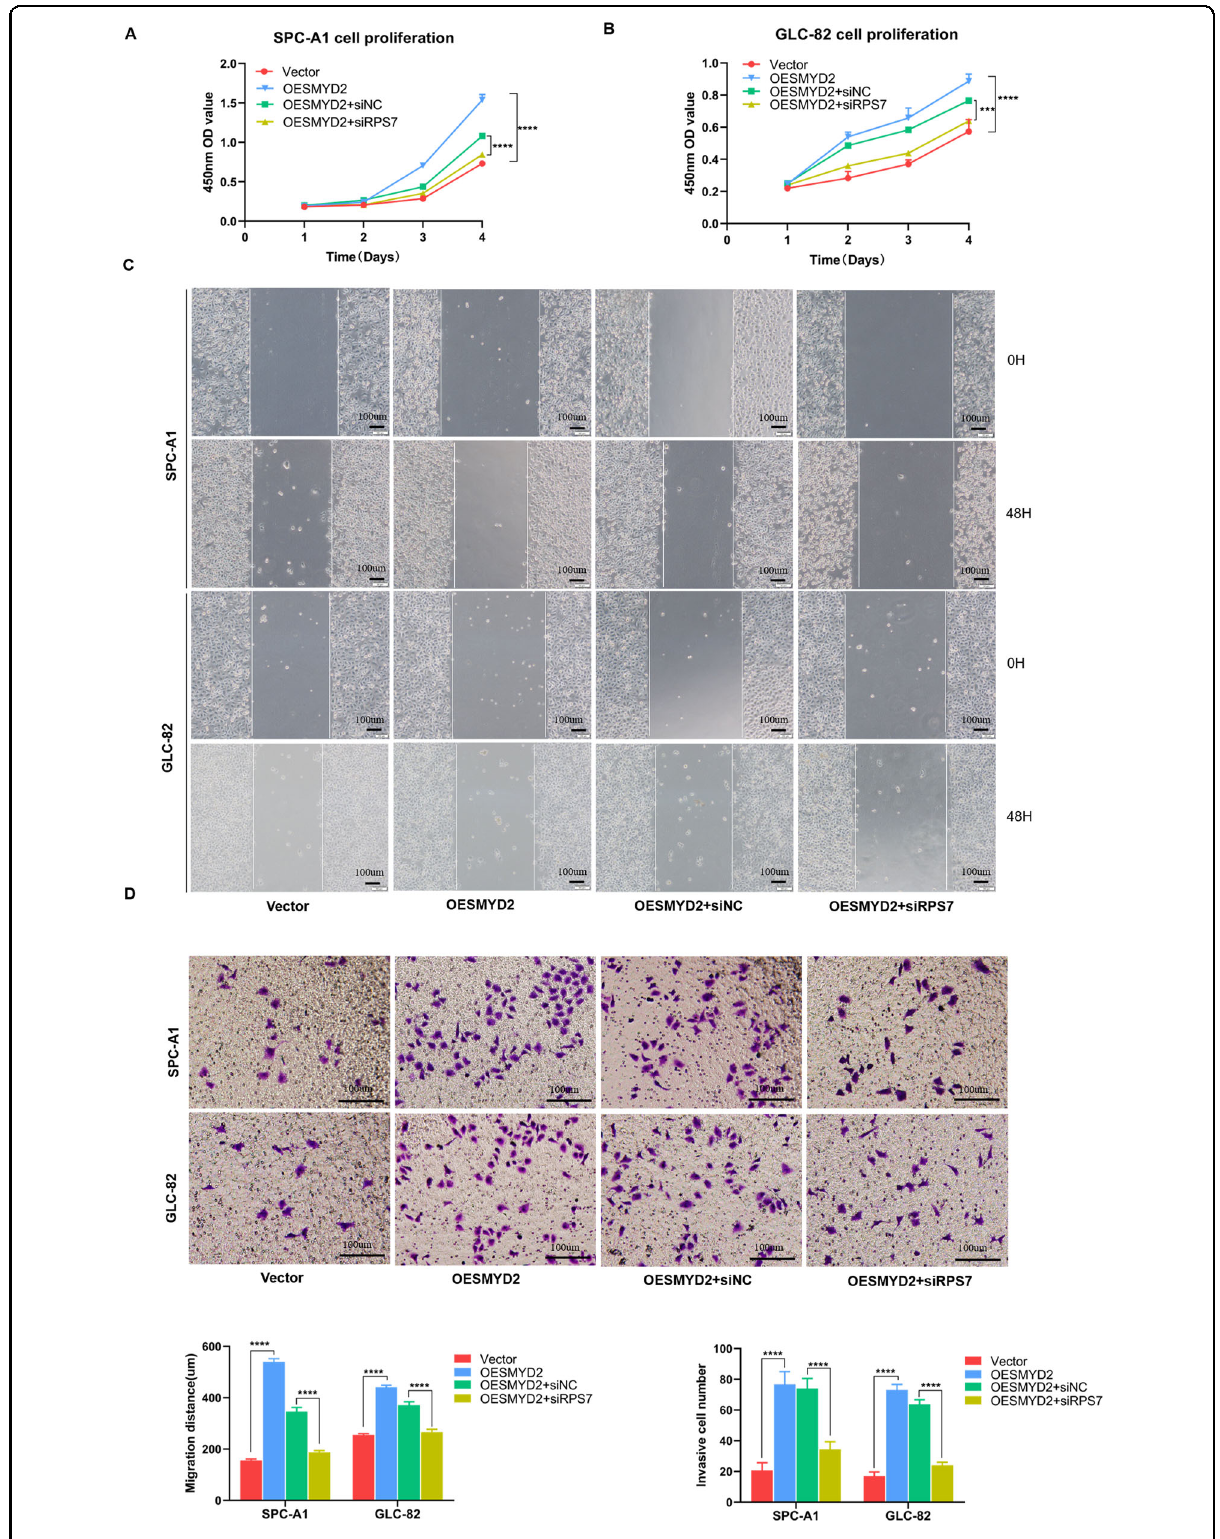
Fig. 6 SMYD2 promotes LUAD carcinogenesis and metastasis mediated by RPS7. A , B CCK8 assay showed that RPS7 depletion partially reversed SMYD2-enhanced proliferation in SPC-A1 and GLC-82 cells. C , D RPS7 depletion attenuated the effect of SMYD2 on cell invasion and migration, as measured by wound healing and transwell assay. The images represent one fi eld under the microscope (×200 magni fi cation). *** p < 0.001; **** P < 0.0001 compared with unpaired T test. Scale bars, 100 μ